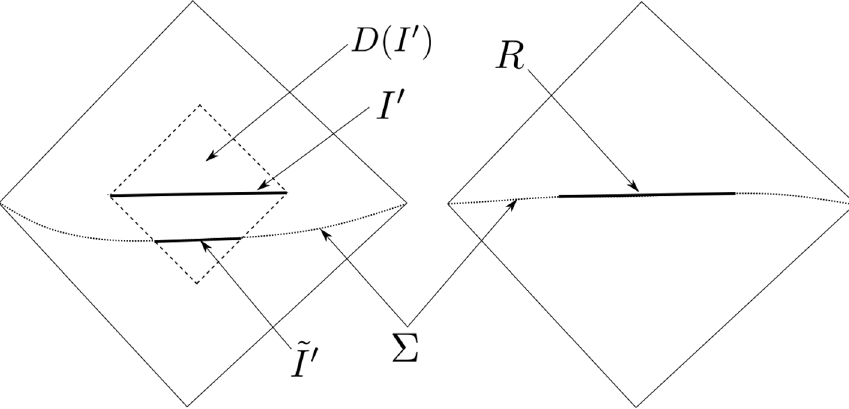
Figure 1 : Two (asymptotically flat) quantum systems, one with dynamical gravity and one without. R is a region in the non-gravitating system, and I 0 a region in the gravitating system. Σ is a time slice, and ˜ I 0 the representative of I 0 on that time slice as defined in (2.5). If I 0 satisfies conditions (2.1) and (2.3) then it is an island detector for R .